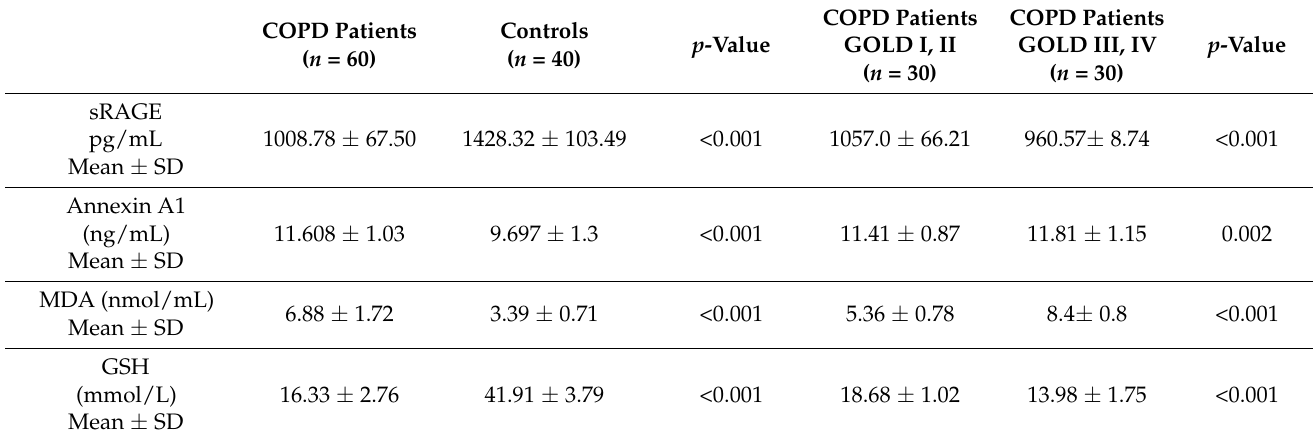
Data are presented as the mean ± SD. The bold value indicates statistical significance. Abbreviations: COPD, chronic obstructive pulmonary disease; sRAGE, soluble receptor for advanced glycation end products.